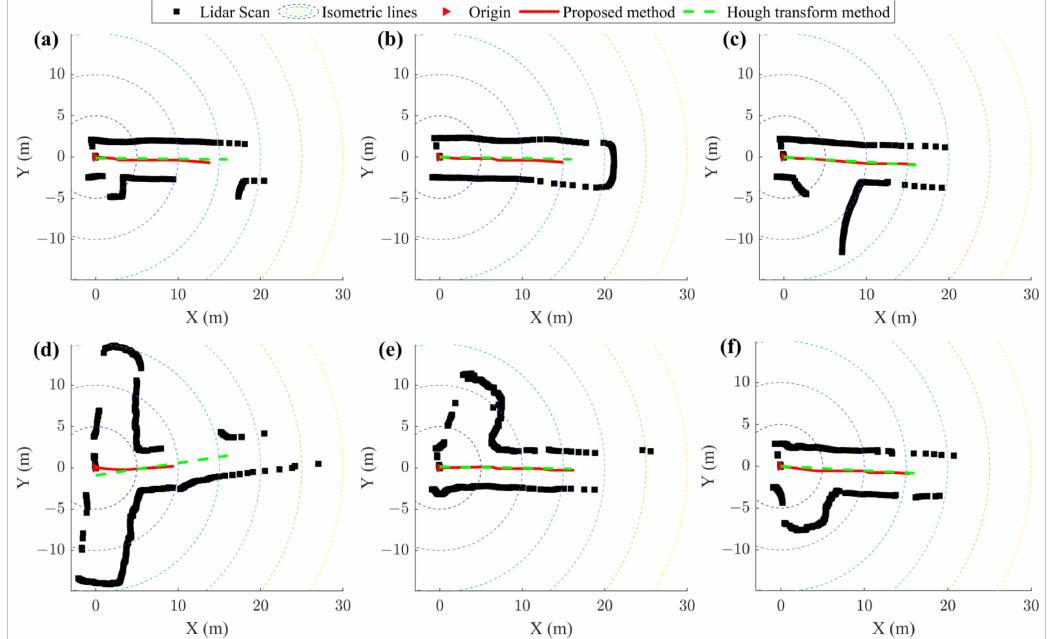
Figure 7. The local path planning of different methods for dataset 1 in the case of traveling straight, in which the red lines and the green lines in ( a – f ) are shown as the local path planning of the proposed method and the Hough transform method, respectively.